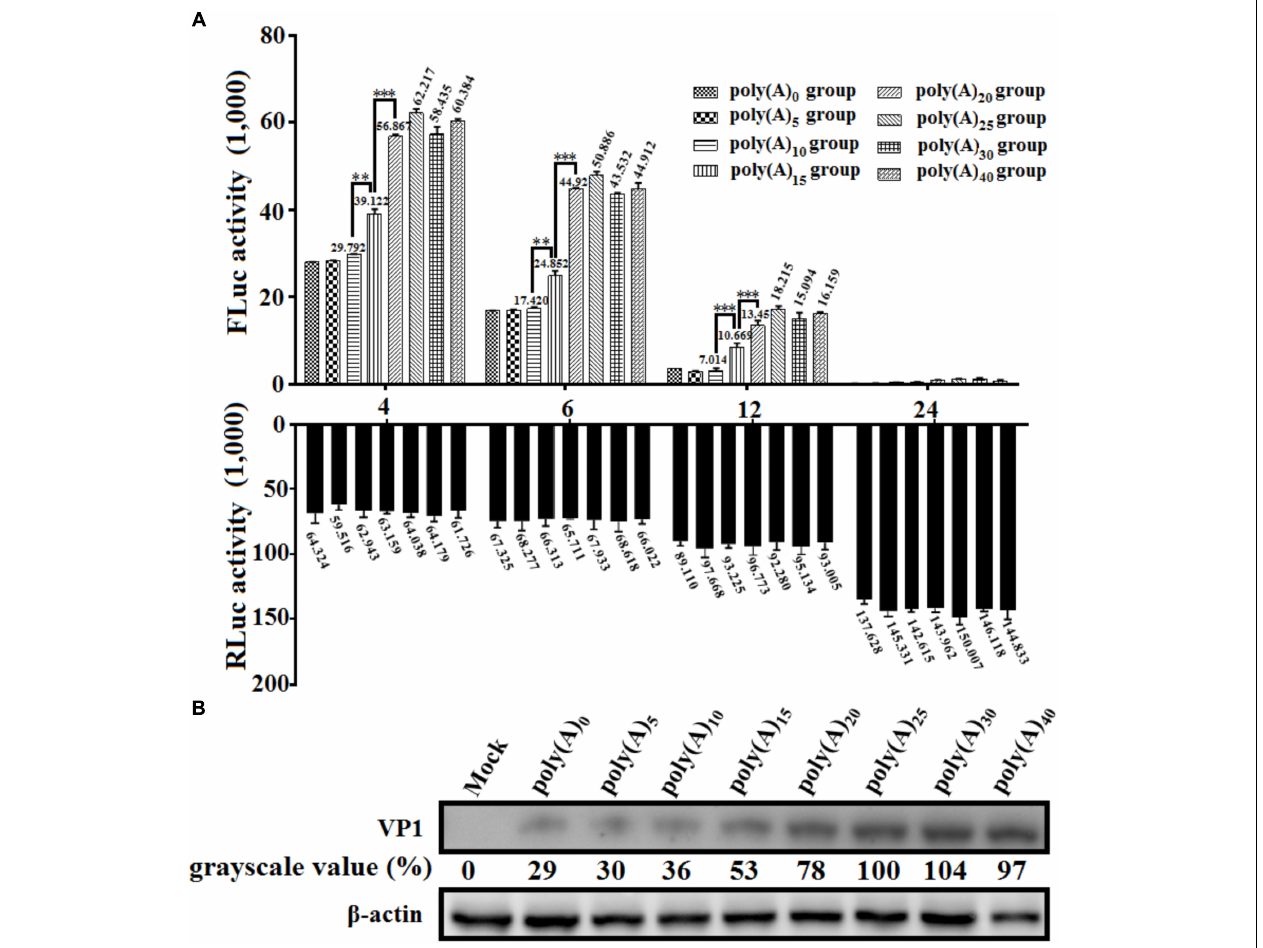
FIGURE 7 | The effects of poly(A) tail length on IRES-mediated translation efficiency. (A) In vitro transcribed RNAs (0.8 µ g) derived from linearized monocistronic reporter plasmids pDHAV-1-An containing various lengths of the poly(A) tail (n: 0, 5, 10, 15, 20, 25, 30, and 40) were co-transfected into DEFs with 0.1 µ g of pGMLR-TK plasmid. Cell lysates were collected at 4, 6, 12, and 24 hpt to measure FLuc/RLuc activity. Columns and bars represent means and standard deviations, respectively, of three independent transfections. ∗∗∗ P < 0.001, ∗∗ P < 0.01. (B) The RNA-launched infectious clone pR-DHAV-1-An was transfected into DEFs, and the cell lysates were collected at 4 hpt for western blot analysis with anti-DHAV-1 monoclonal antibody 4F8 and HRP-labeled goat anti-mouse antibody. The grayscale value in poly(A) 25 group was set as 100%.